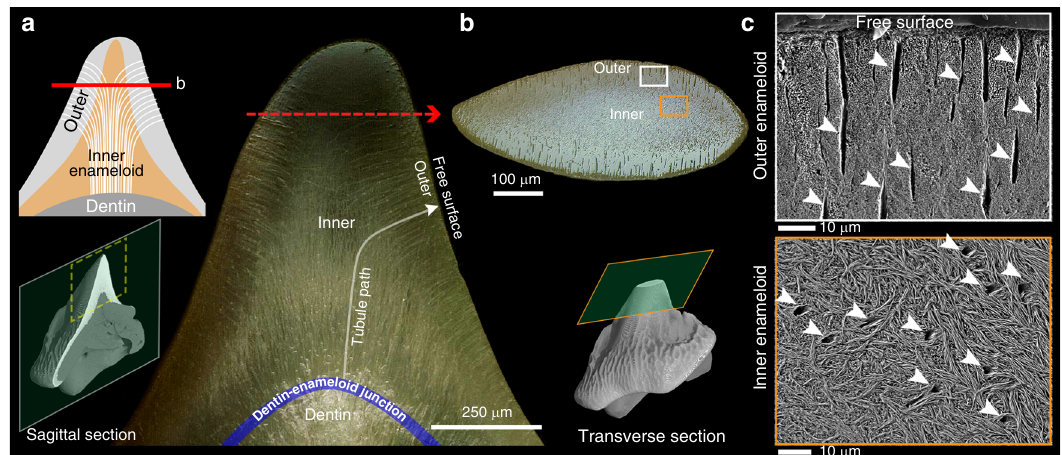
Fig. 2 Microtubules in the enameloid layer of the Port Jackson shark teeth. a Dark- fi eld optical micrograph of a sagittal section, and b bright- fi eld optical micrograph of a transverse section of the cusp (rows 6 – 7) showing the paths of tubules from the inner toward the outer enameloid at the free surface of the cusp. c SEM micrographs, showing that the arced morphologies of microtubules result in their being cross- vs. longitudinally sectioned in the inner vs. outer enameloid, respectively